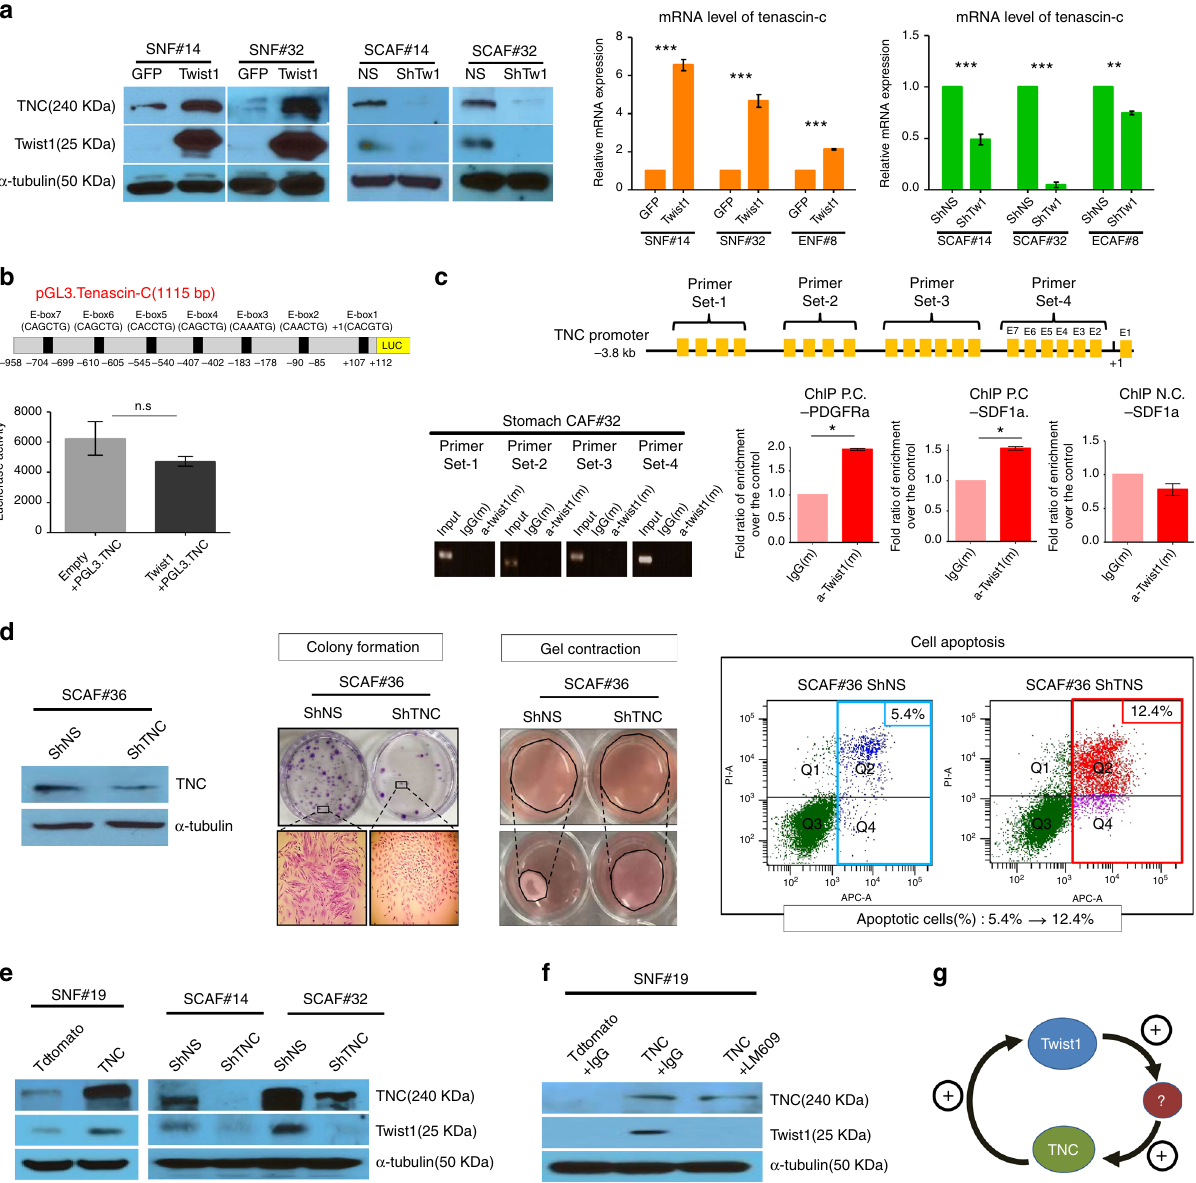
Fig. 1 Twist1 increases tenascin-c expression in cancer-associated fi broblasts. Twist1 is a potent but indirect inducer of tenascin-c (TNC), which is essential for maintaining Twist1 expression in cancer-associated fi broblasts (CAFs). a Normal fi broblasts were transduced with Twist1 encoding lentivirus or GFP control. Induced Twist1 expression increased both the protein and mRNA of TNC in stomach normal fi broblasts (SNF#14 and SNF#32) and esophageal normal fi broblasts (ENF#8). CAFs were transduced with lentivirus-expressing shRNA speci fi c for Twist1 (shTw1) or nonspeci fi c shRNA (shNS). Knockdown of Twist1 also decreased the TNC expression in the esophageal and stomach cancer-derived CAFs (ECAF#8, SCAF#14, and SCAF#32). Real- time RT-PCR data are presented as the mean ± SEM; N = 3 independent experiments (two-tailed t test: ** p <0.001, *** p <0.0001). b We transfected HT1080 cells with TNC promoter-driven ( − 938~ + 112bp) luciferase reporter genes simultaneously with a Twist1 expression vector. Although we added Twist1, the luciferase reporter assay revealed that Twist1 did not enhance the TNC promoter activity. Data are presented as the mean ± SEM; N = 4 independent experiments (two-tailed t test: ns not signi fi cant). c The chromatin immunoprecipitation assay indicated that Twist1 did not bind to any E-box sequences between − 3.8kb and + 25bp of the TNC transcription start sites. In contrast, Twist1 bound to independent positive controls such as E-box sequences in the PDGFRa and SDF1a promoter (ChIP P.C-PDGFRa / SDF1a) but not to negative control, non E-box sequence in SDF1a promoter (ChIP N.C.- SDF1a). Data are presented as the mean ± SEM; N = 3 independent experiments (two-tailed t test: * p <0.05). d The shRNA-mediated depletion of TNC led to decreased colony formation and gel contraction abilities in stomach cancer-derived CAFs (SCAF#36). The TNC silencing also increased the proportion of apoptotic cells. e Exogenous TNC expression in normal fi broblasts (SNF#19) enhanced the Twist1 expression, whereas the TNC depletion in stomach cancer-derived CAFs (SCAF#14 and #32) led to Twist1 downregulation. f TNC-induced Twist1 expression was mediated by Integrin β 3. LM609 (Integrin β